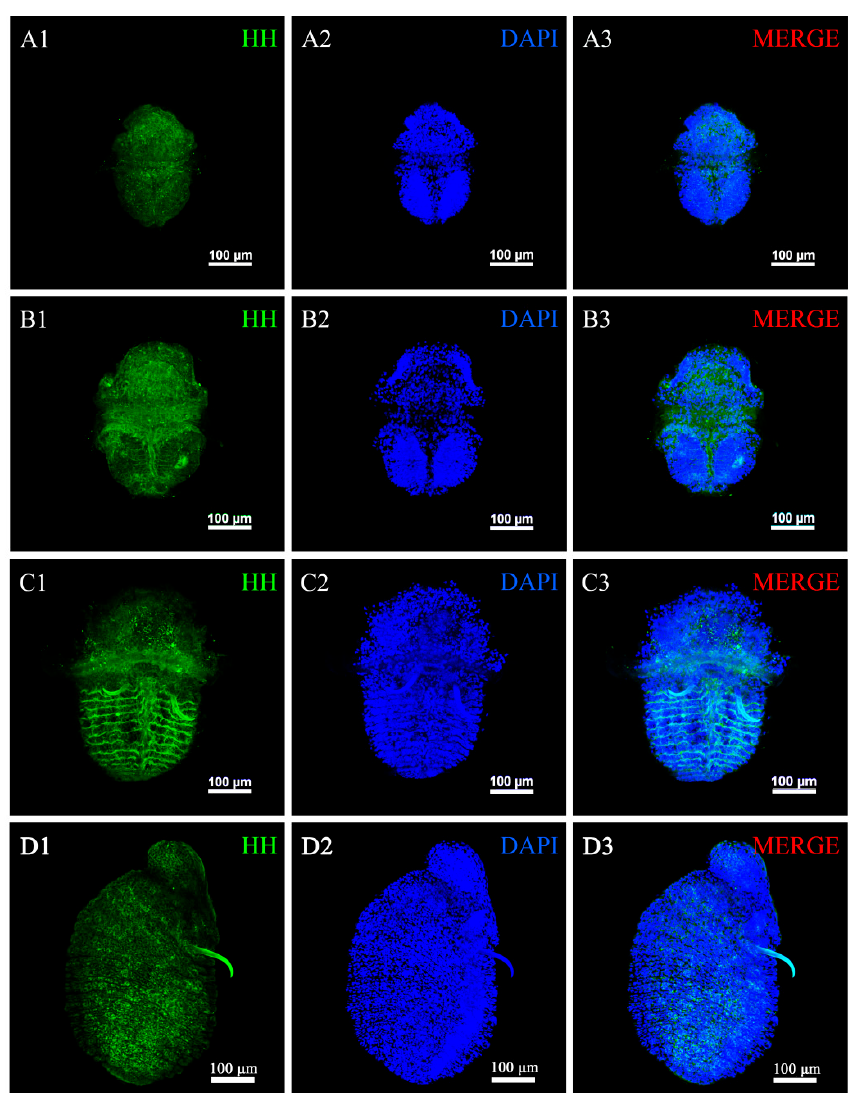
Figure 7. Immunofluorescence assay of HH in U. unicinctus larvae during the segment formation and secondary loss. ( A – D ) correspond to LT, ES, SL, and WL of U. unicinctus , respectively. ( A – C ), ventral views; ( D ), lateral view.